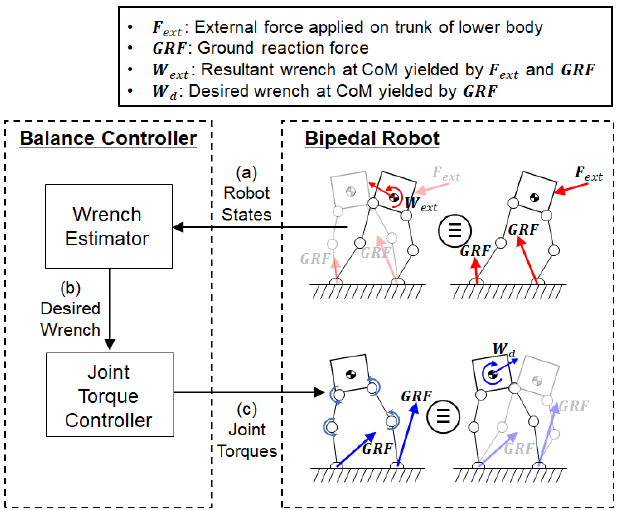
Figure 2. Overview of the balance control system: A wrench estimator uses ( a ) the CoM states of the bipedal robot to predict ( b ) the desired wrench at the CoM. A joint torque controller calculates ( c ) the joint torques required to achieve the desired wrench at the CoM.